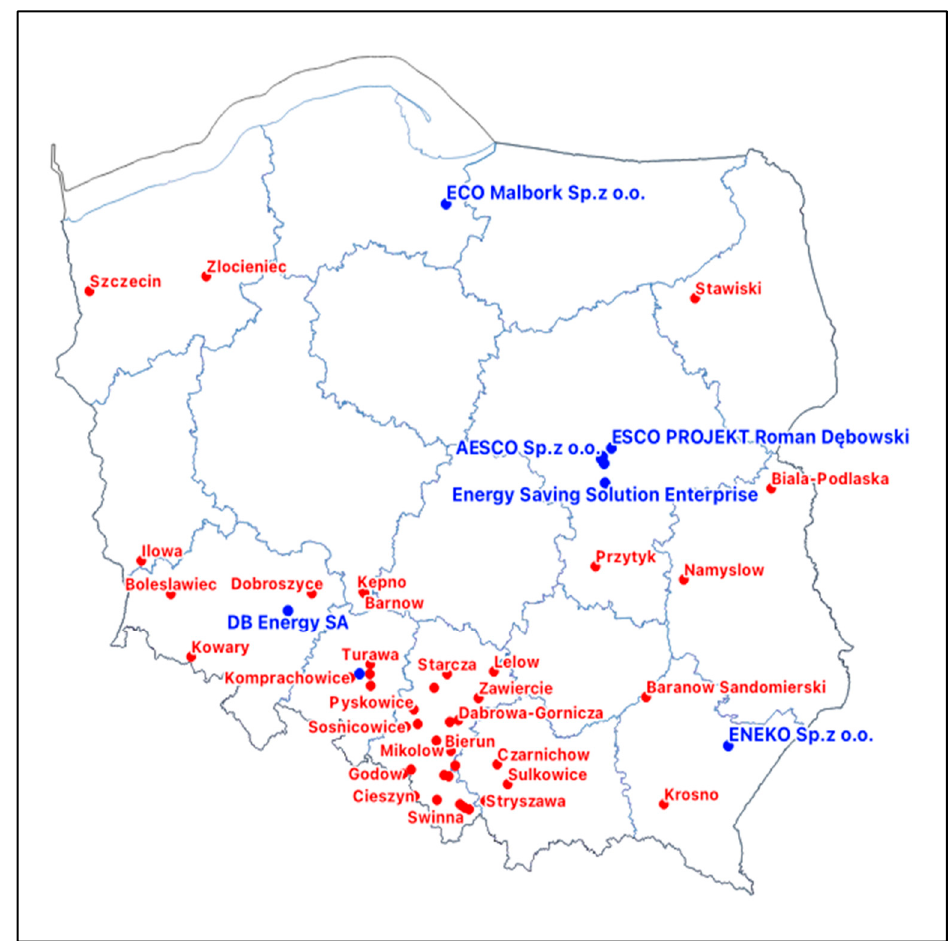
Figure 1. The distribution of entities covered by the study on the map of Poland (local government units-in red, enterprises-in blue).